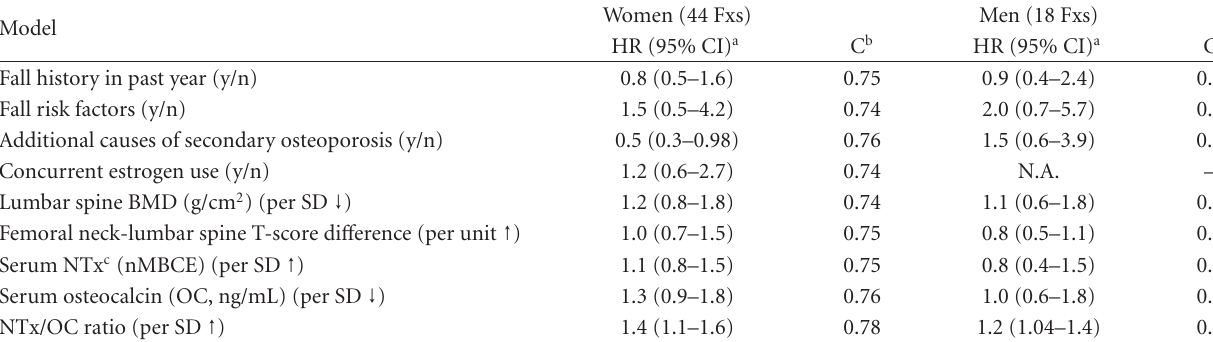
Table 5: E ff ect of additional risk factors to predict first major osteoporotic fracture (Fx) over 10 years among Rochester, MN women